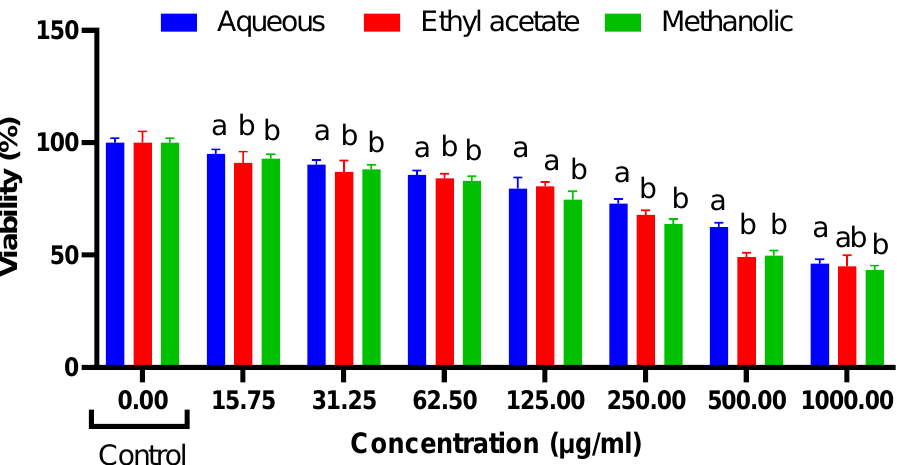
Figure 4. Cell cytotoxicity on HT-29 cells (one-way ANOVA, different letters indicate significant difference between extracts in the same concentration (a, b and c), p ≤ 0 .05.).